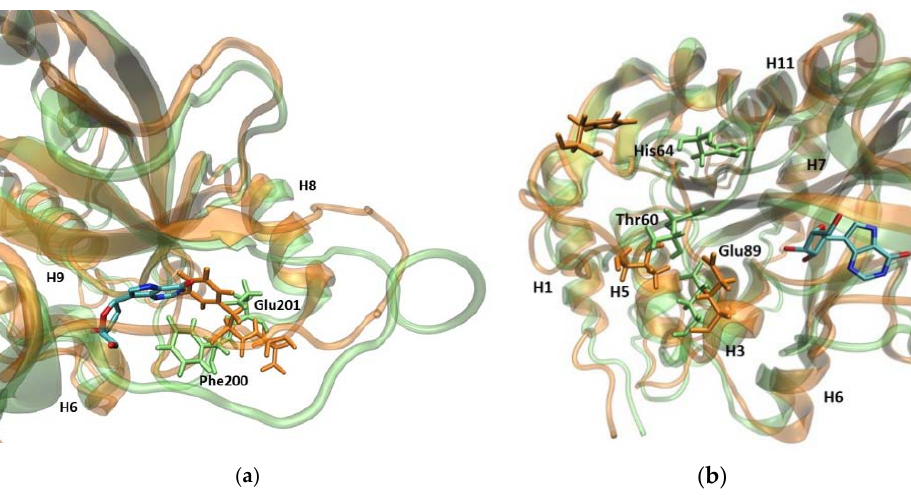
Figure 5. Superposition of the trajectory snapshots showing the active site amino acids in the WT1 PNP (orange) and WT3 PNP (green). The substrate analogue (9-deazainosine) bound to the biologically active WT3 PNP is also shown (colored by the atom types) to better visualize the changes in the geometry of the active site pocket occurring in the WT1 PNP. The ligand was not present in the simulations, its location is from the X-ray structure of the WT PNP trimer (PDB 1A9P [21]). ( a ) In the monomeric enzyme, Phe200 is solvent-exposed, while in the trimeric form, it is located at the monomer–monomer interface, so when neighbouring subunits are not present, Phe200 moves into a hydrophobic pocket within the monomer. This causes Glu201 to shift away from the active site pocket of the enzyme. ( b ) When the loop containing the active site His64 changes its position in the WT1 PNP, the interaction between Thr60 and Glu89 is broken, causing Glu89 to also